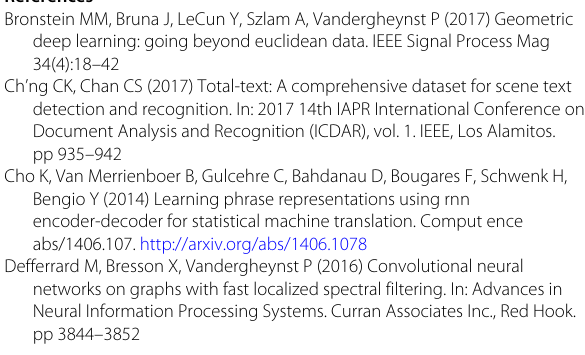
Abbreviations TRN: Text relation networks; LSTM: Long short-term memory; GCNs: Graph convolutional neural networks; CNNs: Convolutional neural networks; GAT: Graph attention network; VQA: Visual question answering; RoIs: Regions of interest; FPN: Feature pyramid networks; RPN: Region proposal network; NMS: Non-maximum suppression; IoU: Intersection-over-union; SAGL: Spatially adaptive graph learner; GFPN: Graph feature pyramid network; GRU: Gate recurrent